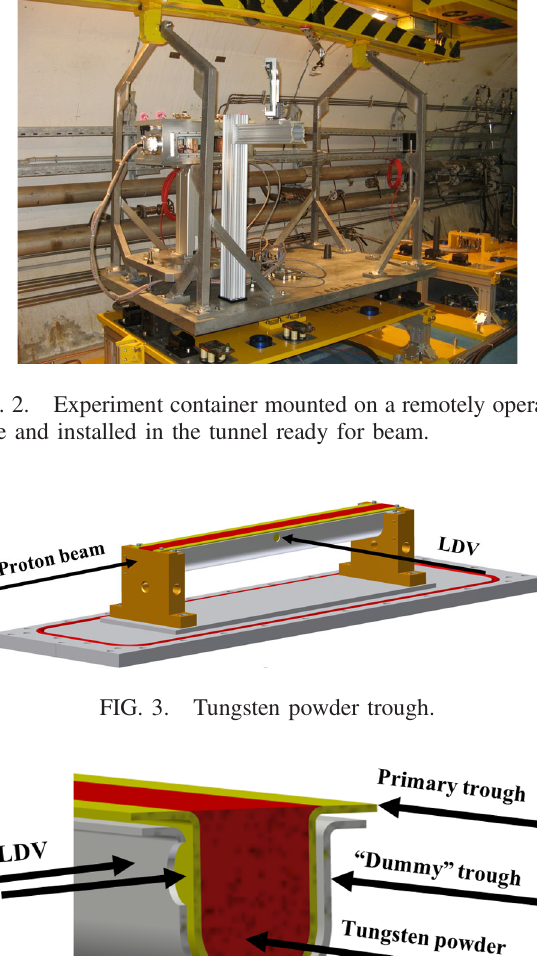
FIG. 6. Microscope image of tungsten